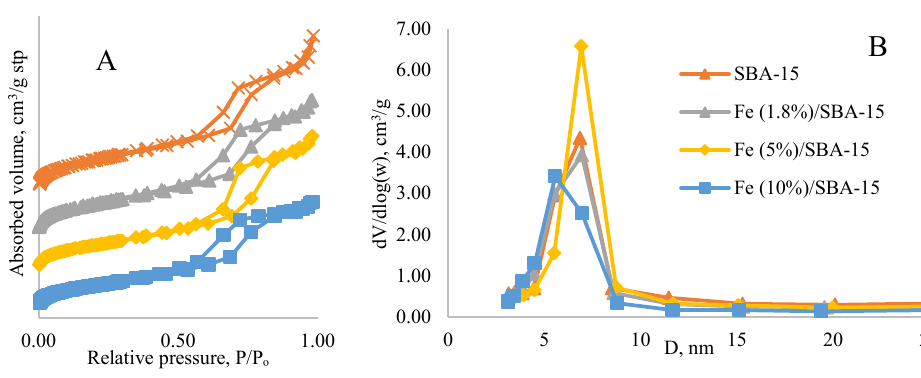
Fig. 2. N 2 physisorption isotherm (A) and pore size distribution (B) of SBA-15, Fe (1.8 %)/SBA-15, Fe (5 %)/SBA-15, Fe (10